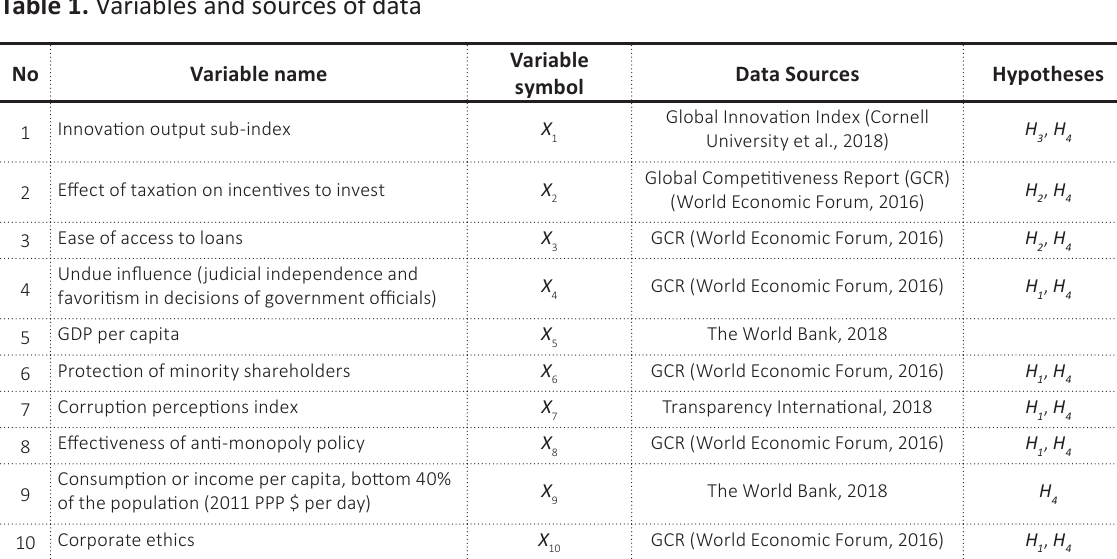
Table 1. Variables and sources of